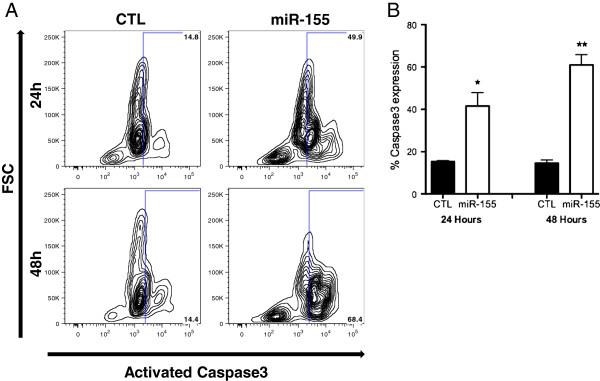
Effect of miR-155 overexpression on the expression of Cleaved Caspase-3. Cleaved caspase-3 expression was confirmed to be upregulated in miR-155 transfected cells by a flow cytometry based assay (A) flow plots of activated caspase-3 in miR-155 overexpressing or CTL cells at 24 h and 48 h (B) significant increase in the percentage of cells expressing activated caspase-3. Statistical significance determined using Paired Two Tailed t-Test, *p < 0.05, **p < 0.01; n = 4.